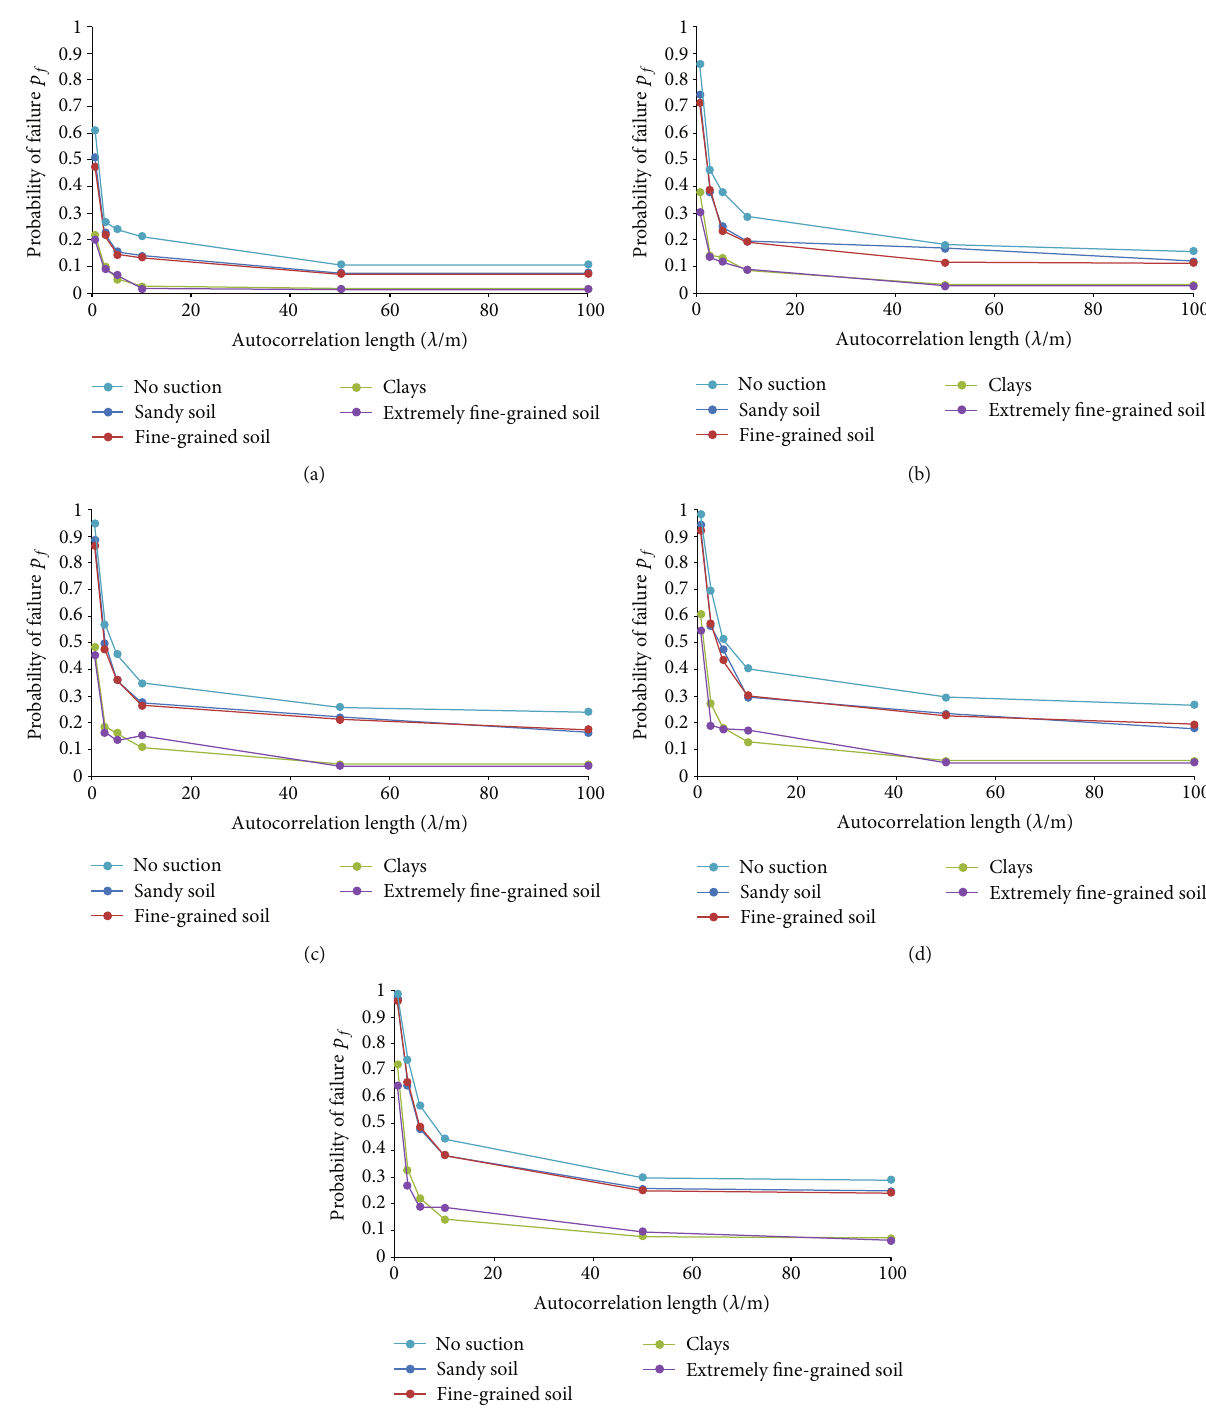
= − 1 : 0 , (b) ρ = − 0 : 5 , (c) ρ = 0 , (d) ρ c ′ tan ϕ ′ c ′ tan ϕ ′ c ′ tan ϕ ′ c ′ tan ϕ ′